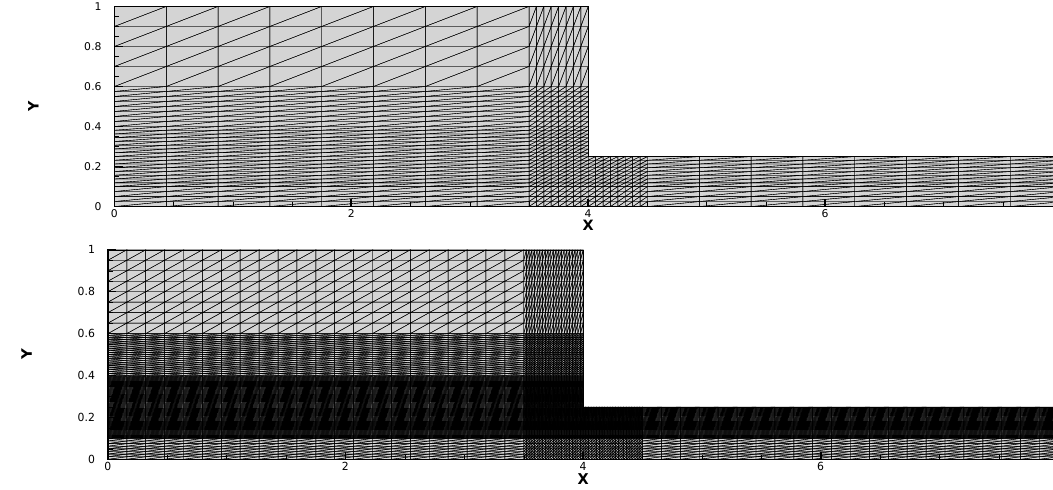
Figure 1. The geometry of contraction mesh for one-level ( up ) and two-level ( down